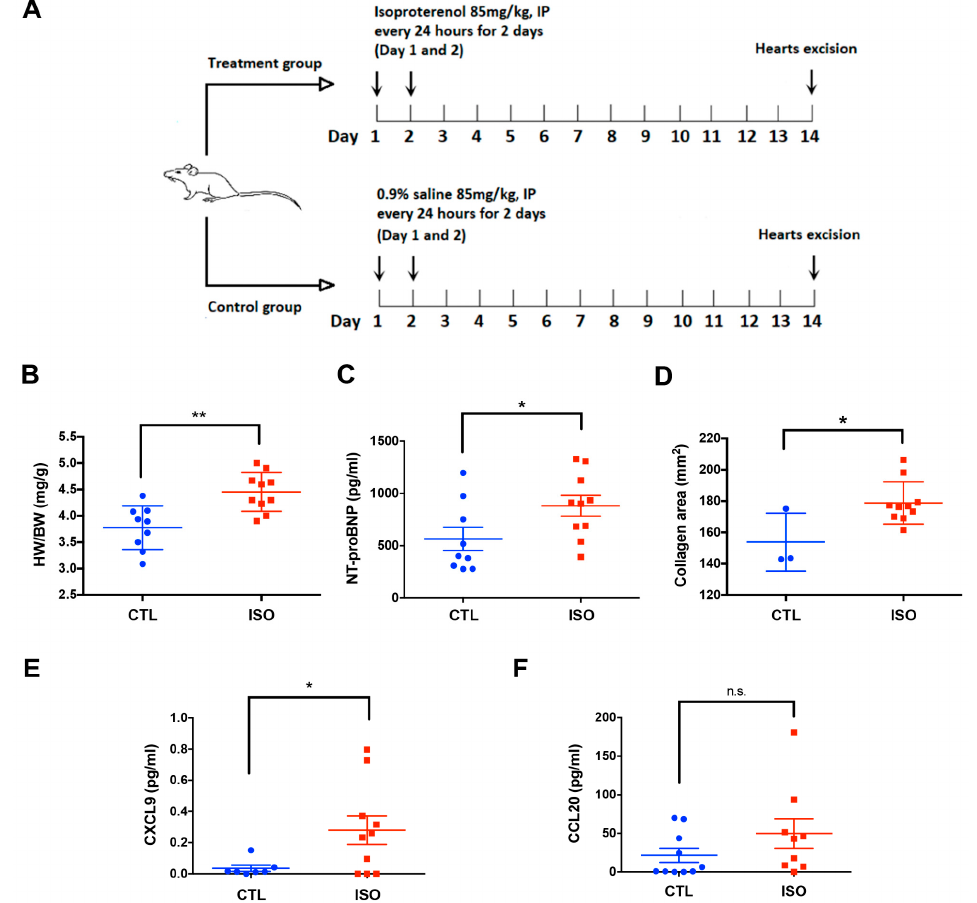
Figure 5. ISO-induced MI and post-MI cardiac fibrosis of rats. ( A ) Protocol of ISO-induced MI in rats. ( B ) HW/BW ratios in ISO-treated and control rats. ( C ) Serum NT-proBNP levels are increased in ISO- treated rats. ( D ) Heart sections of ISO-treated rats exhibited more collagen areas than control rats. ( E ) Serum CXCL9 levels are increased in ISO-treated rats. ( F ) Serum CCL20 levels in ISO-treated rats are not significantly increased compared to control rats. BW = body weight; CTL = control; HW = heart weight; IP = intraperitoneal; ISO = isoproterenol; MI = myocardial infarction; NT-proBNP = N- terminal prohormone of brain natriuretic peptide. Results are presented as mean ± SEM.